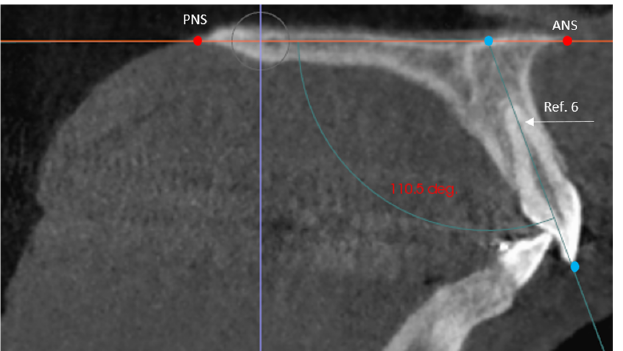
Figure 3. Reference lines used for incisor inclination on the sagittal plane, where PNS and ANS represent the palatal plane and the long axis of the upper incisor (Ref. 6). The angle obtained between both lines defines the incisor